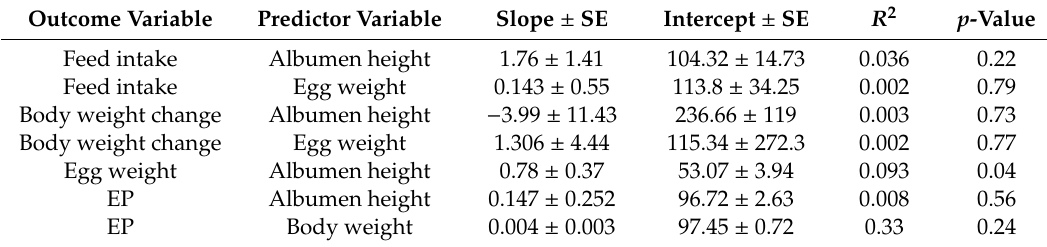
Table A2. Linear regression between hen performance and egg quality indices ( n =